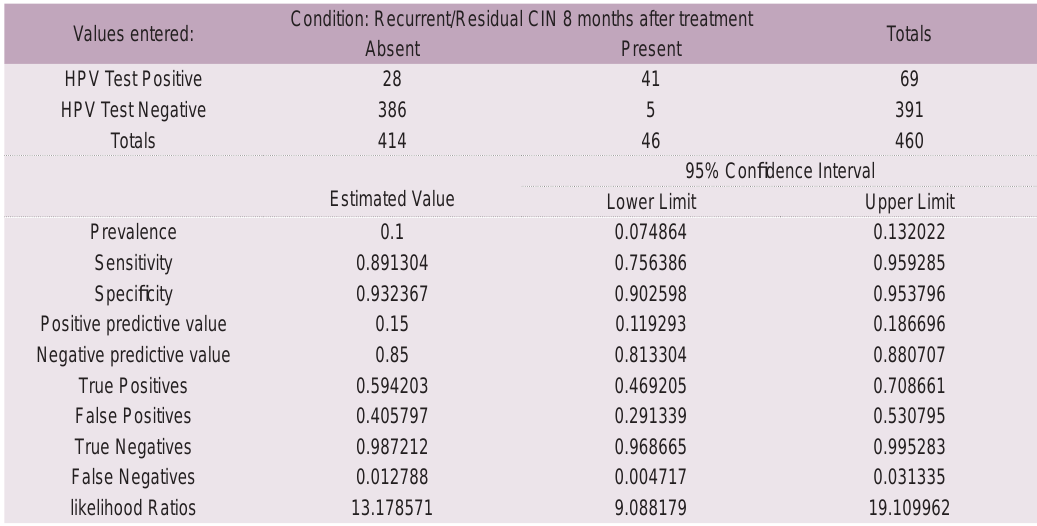
TABLE 1. The role of HPV testing in the follow-up of patients 8 months after treatment for